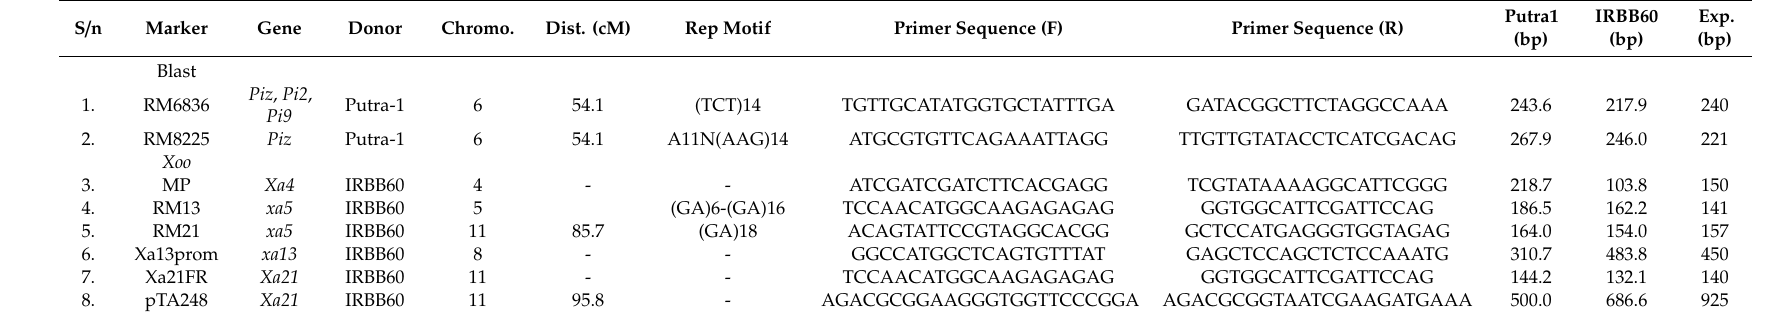
Table 1. Information of markers used for foreground selection of target Xoo and blast resistance